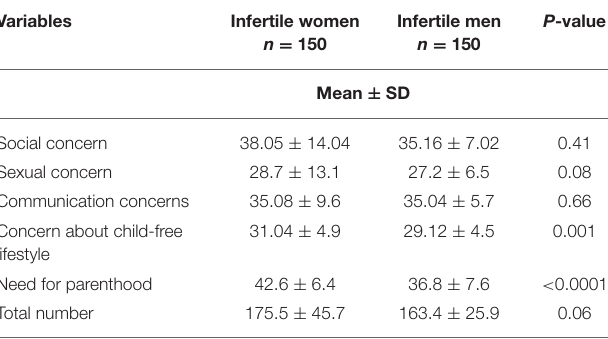
TABLE 3 | Comparison of mean scores of different areas of infertility stress in infertile women and